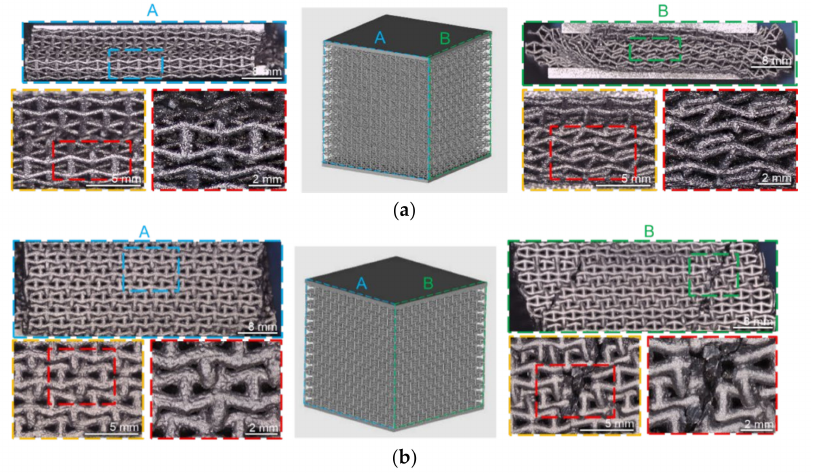
Figure 9. Failure analysis on two surfaces of the auxetic lattice: ( a ) for the 0.5 mm beam diameter specimen (relative density of 0.08), surface A shows beams collapsing and closing the re-entrant cell space, surface B shows shearing of planes; ( b ) the 1 mm beams (relative density of 0.27) show similar behavior on surface A , but surface B shows fracture along inclined